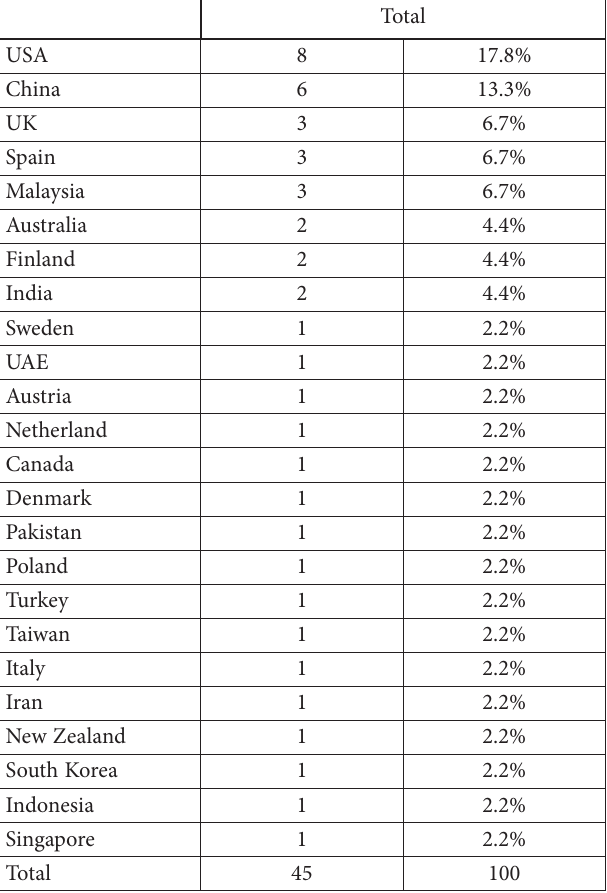
Table 7. Countries of author’s institution (source: authors,